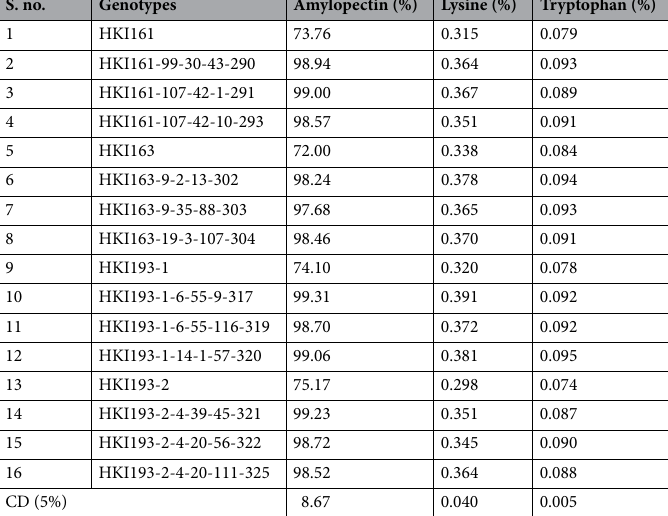
Table 4. Nutritional quality attributes among introgressed progenies and their respective recurrent.